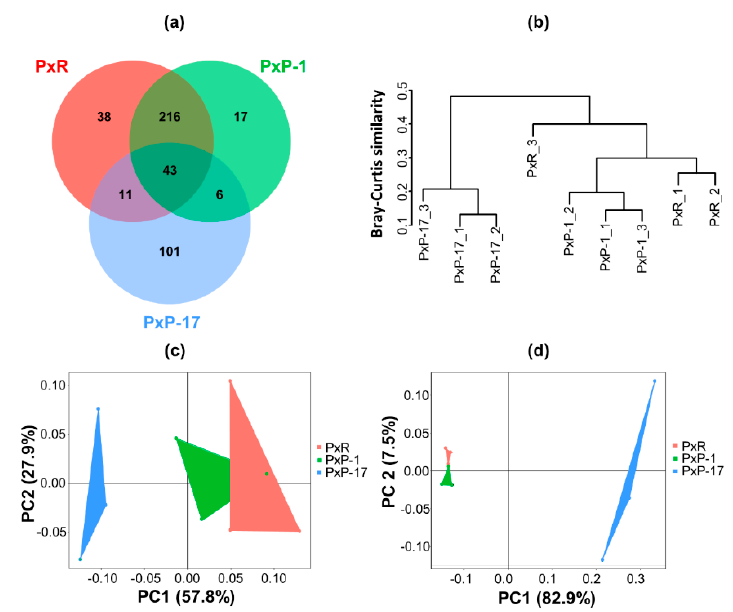
Figure 2. Diversity of the gut microbiota in different P. xylostella populations . ( a ) Venn diagram of operational taxonomic units (OTUs) in PxR, PxP-1, and PxP-17; ( b ) Cluster diagram including all samples based on Bray–Curtis distance dissimilarity; Principal Coordinate Analysis of ( c ) weighted UniFrac distances and ( d ) unweighted UniFrac distances, based on OTUs calculated at 97% similarity. PxR: P. xylostella feeding on radish; PxP-1 and PxP-17: the 1st and 17th generation of P. xylostella , respectively, feeding on peas after host shift from radish.